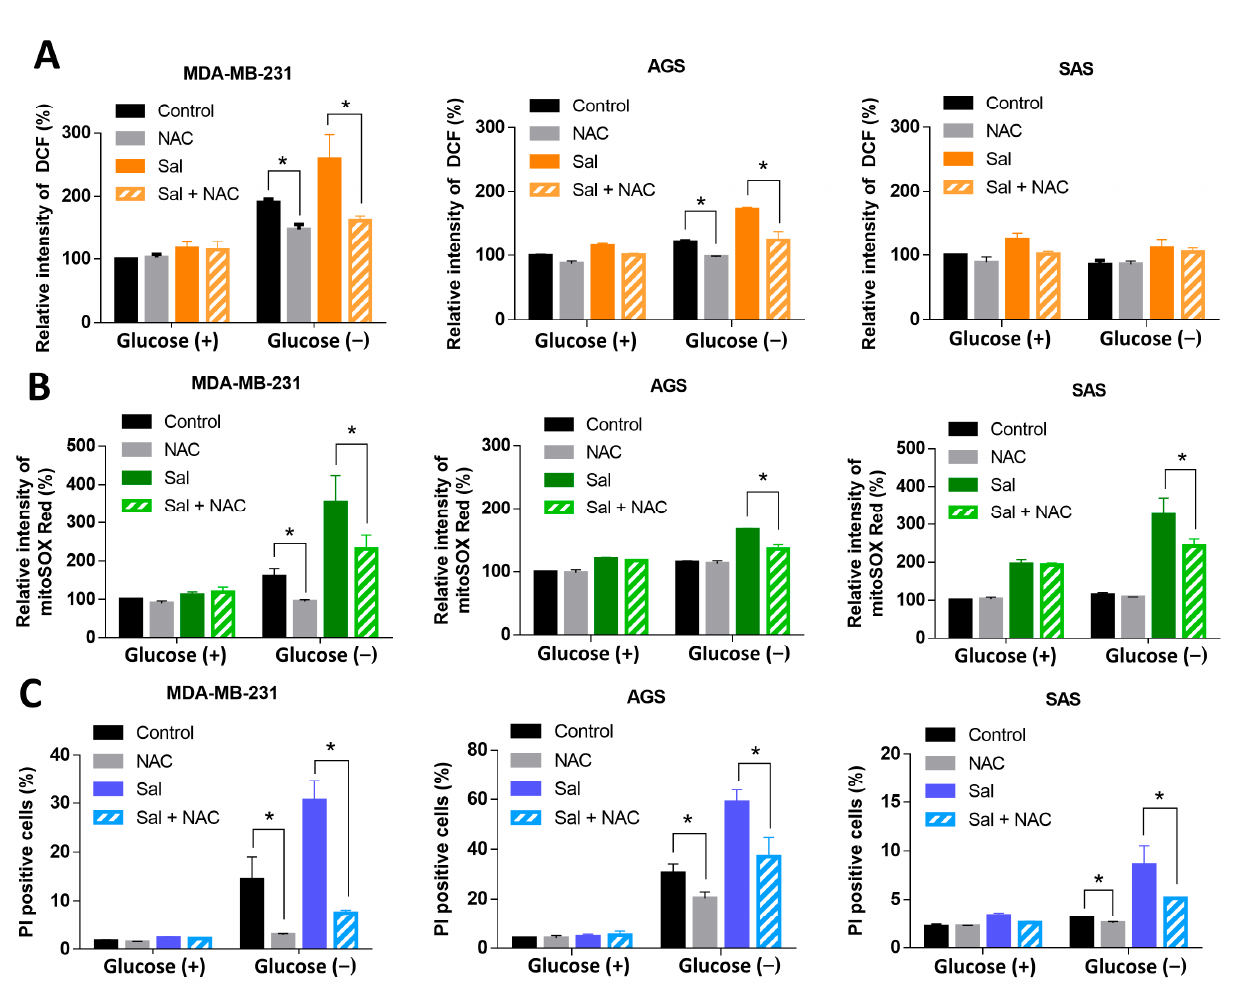
Figure 3. ROS involved in salubrinal enhanced-cell death rate during glucose deprivation. The cells were treated according to the study design with or without 30 µ M of salubrinal and/or 1 mM of N-acetyl-cysteine (NAC) for 24 h. ( A , B ) The levels of intracellular ROS (icROS) and mitochondrial ROS (mtROS) were detected using flow cytometry with DCFH-dA staining ( A ) and mitoSOX Red dye ( B ). The measured value of ROS from the control group under glucose-containing conditions was normalized to 100%. ( C ) The cell death rate was evaluated by a PI exclusion assay. The data are presented as the means ± SEMs of the results from three independent experiments. * p < 0.05. NAC: N-acetyl-cysteine. Sal: salubrinal. Glucose (+): medium with 25 mM of glucose. Glucose ( − ): glucose-free